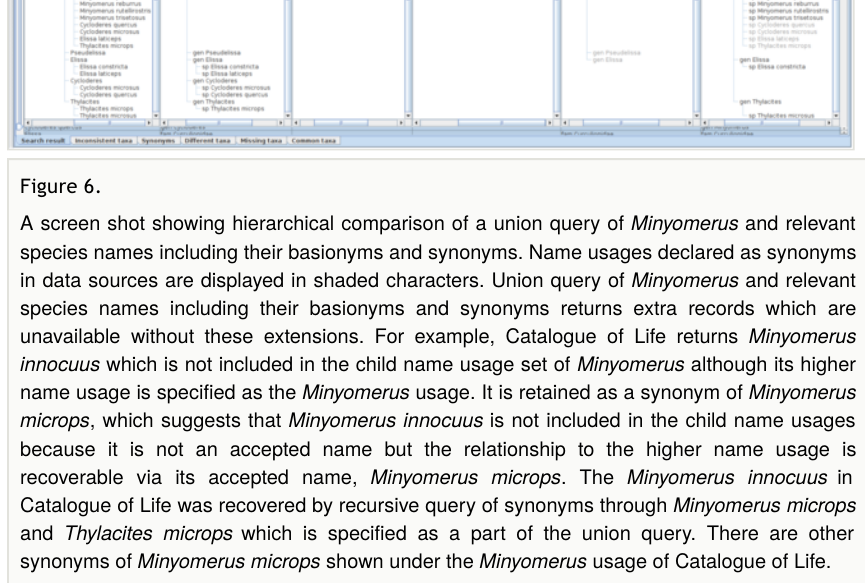
The lower part of the table shows a distribution of name usages in hierarchies with categorisation based on analysis during composition of the aligner tree (Fig. 7), i.e. name usages that appeared in all hierarchies sharing the same name literal and higher name usages, or di ff erent in higher name usage, name usages missing in some hierarchies, inconsistent name usages, synonyms, and all name usages. Each cell contains the higher name usage of the name literal on the line. Inconsistent name usages are extracted from the composite tree alone, because it retains nodes covering all name usages for the alignment and hence inconsistencies, both inter- and intra-hierarchies, are reproduced in the aligner tree. Synonym tab is designed to show name usages having di ff erent higher names depending on taxonomic views where higher names are not on the path of higher nodes of the composite tree. Synonymous usages also appear in the 'di ff erent taxa' tab because they are di ff erent in their higher name literal. Note that the synonym tab is expected to capture potential synonyms between hierarchies rather than what is stated as a synonym in a single hierarchy.